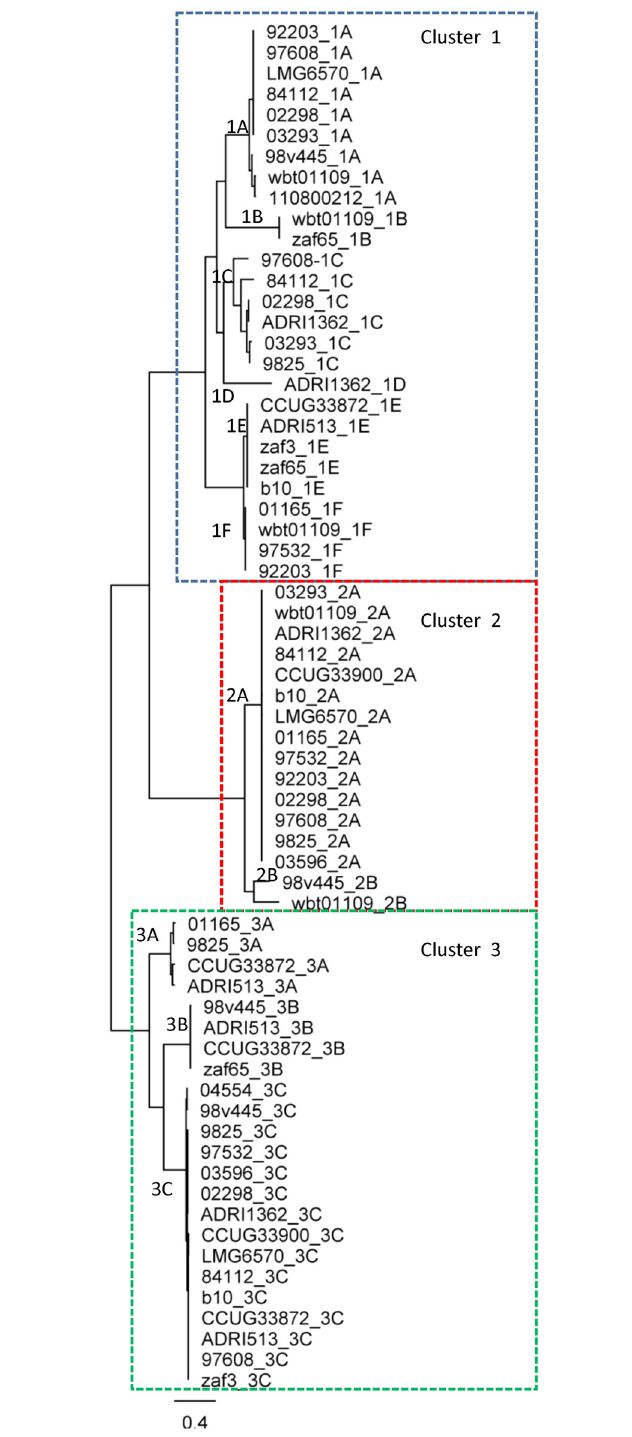
Fig 1. Phylogenetic analysis of virD4 genes. The scale bar represents the mean number of nucleotide substitutions per site. Related virD4 genes are indicated in boxes.